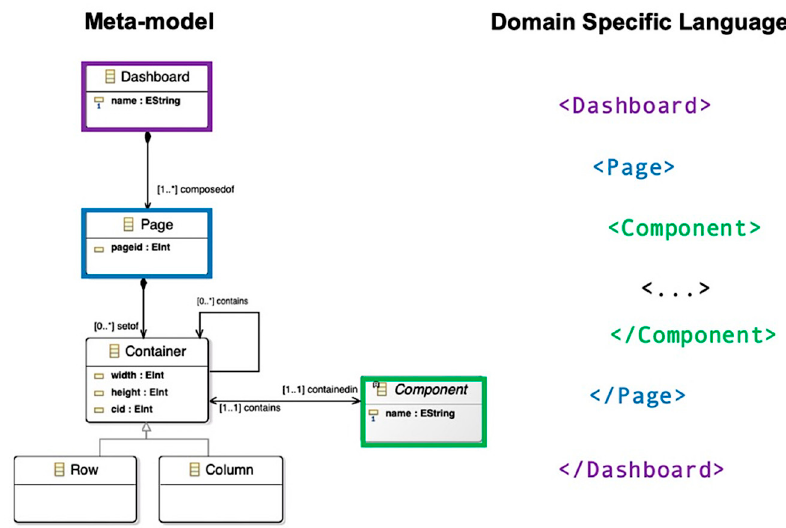
Figure 4. Correspondence between the meta-model entities and the XML entities that are part of the DSL. The subsequent primitives that are part of a component are materialized in the DSL through nested entities and properties, as will be presented in the results section.